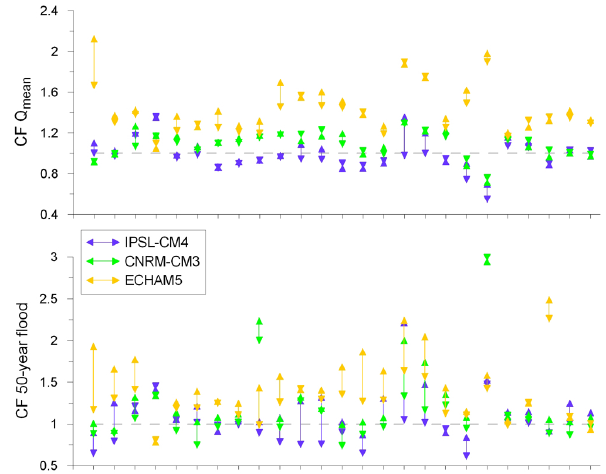
Fig. 4. Range between the two emission scenarios for the Q mean CFs (top) and the 50-year flood level CFs (bottom) for the individual study